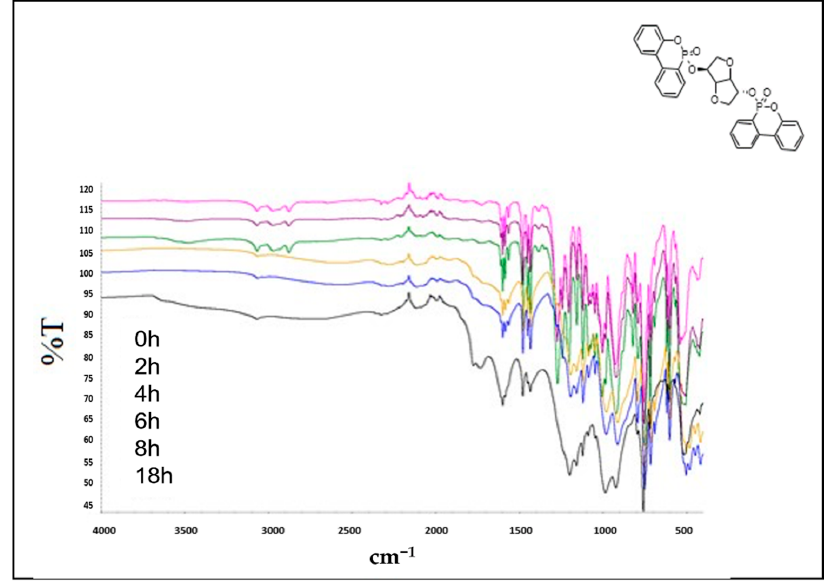
Figure 5. Thermal Degradation of Isosorbide bis -(Diethylphosphate) at 260 °C.